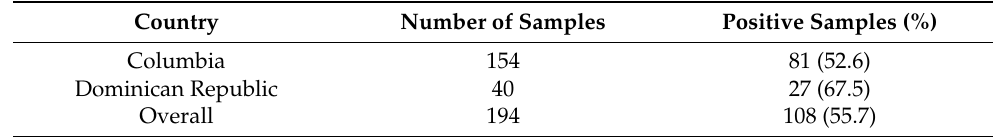
Table 1. ZIKV NS1 antigen-capture ELISA results from patients infected during the 2015–2016 outbreaks in Colombia and the Dominican Republic 1 .